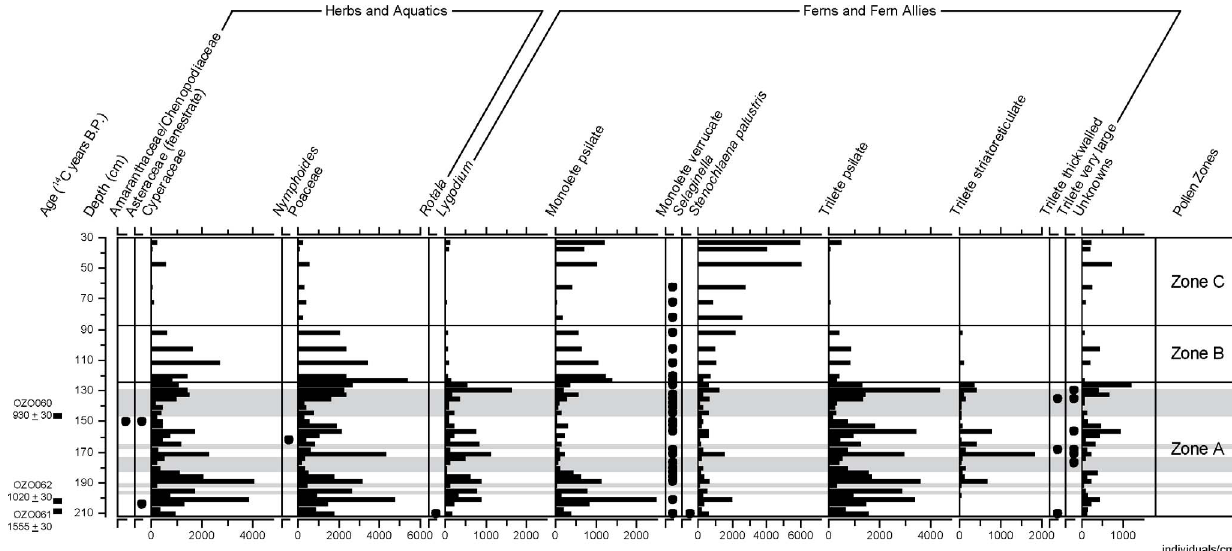
Figure 6. Pollen results (herbs, ferns). Concentration of pollen (individuals per cm 3 of sediment) from herbaceous plants (dryland, wetland and aquatic), ferns, and ‘fern allies’ ( Selaginella , Lycopodiopsida), plotted against depth/age, for core TMR/B. Closed circles represent rare taxa that did not exceed 5% of the total microfossil assemblage in any sample. Light gray shading represents sand beds. Pollen zones based on classification of the whole assemblage.